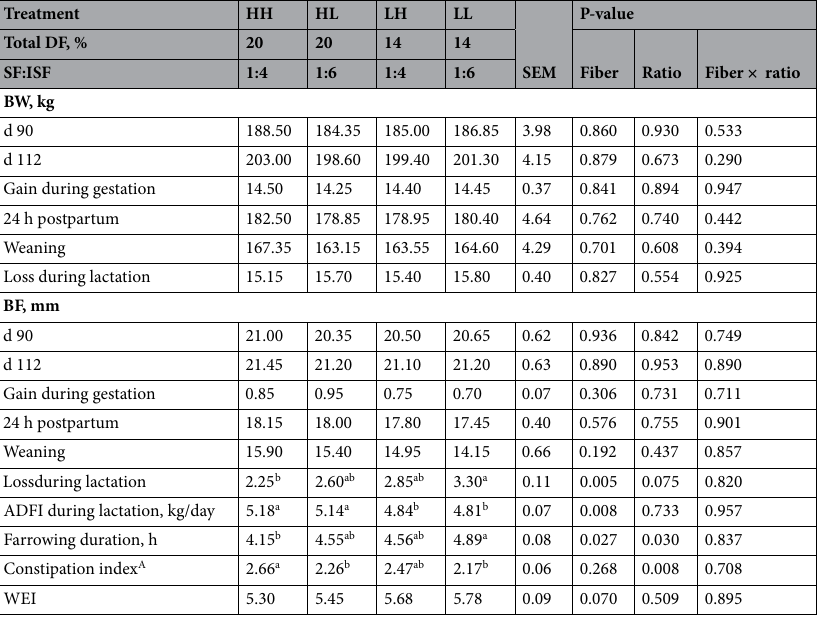
Table 2. Effects of total dietary fiber levels and soluble, insoluble dietary fiber ratio on sow reproductive performance. SEM standard error of means, BW body weight, BF backfat thickness, ADFI average daily feed intake, DF dietary fiber, SF soluble fiber, ISF insoluble fiber. A A score value ranging from 0 to 5: 0 (absence of feces), 1 (dry and pellet-shaped), 2 (between dry and normal), 3 (normal and soft, but firm and well formed), 4 (between normal and wet; still formed, but not firm), 5 (very wet feces, unformed and liquid). a,b Means with different superscripts within rows are significantly different at (P < 0.05).